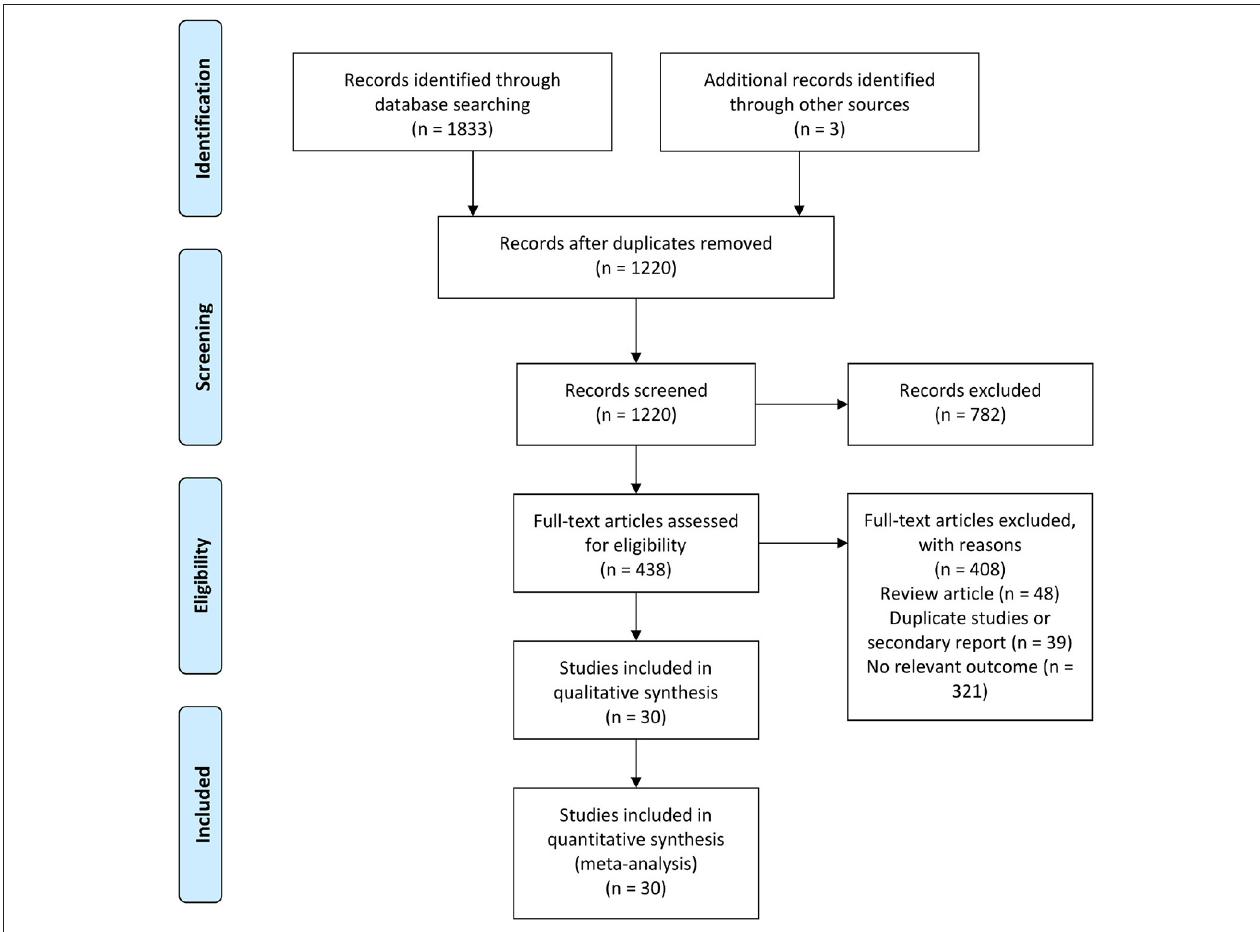
FIGURE 1 | Flow diagram of the evidence search and selection process.